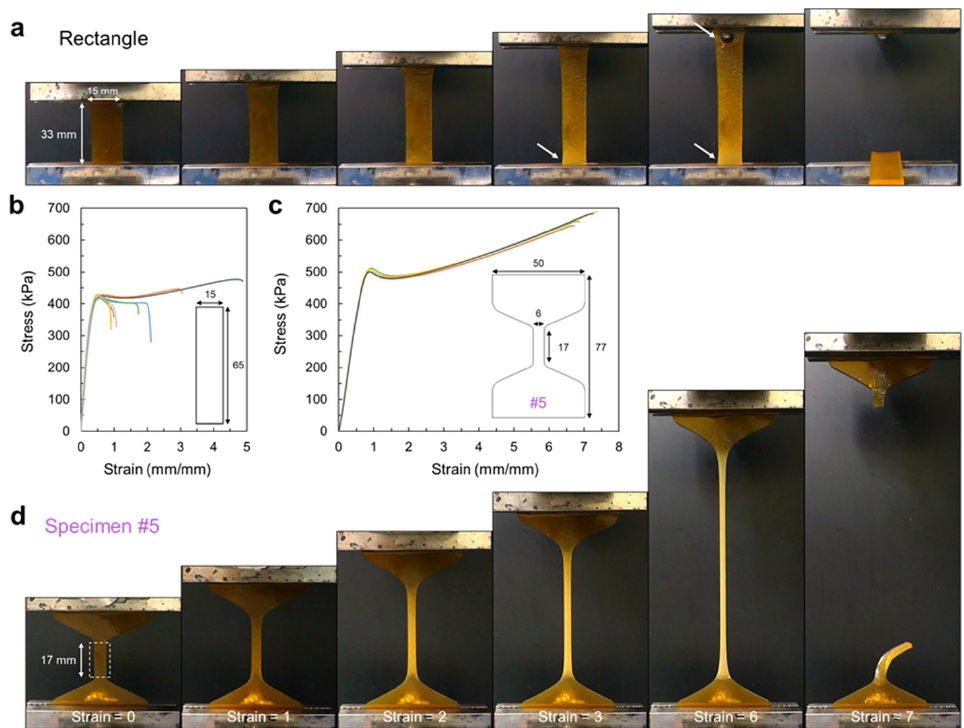
Figure 6. Photographs and stress-strain curves of Fe-crosslinked hydrogels with different shapes. ( a , d ) Photographs of a different stretching process for each hydrogel. Arrows in the photographs indicate the stress concentration near the grip resulting in the abrupt hydrogel rupture. ( b , c ) Stress-strain curves of each hydrogel. All five dumbbell-shaped specimens exhibited notably stable measurements, whereas rectangular specimens always exhibited different measurements.